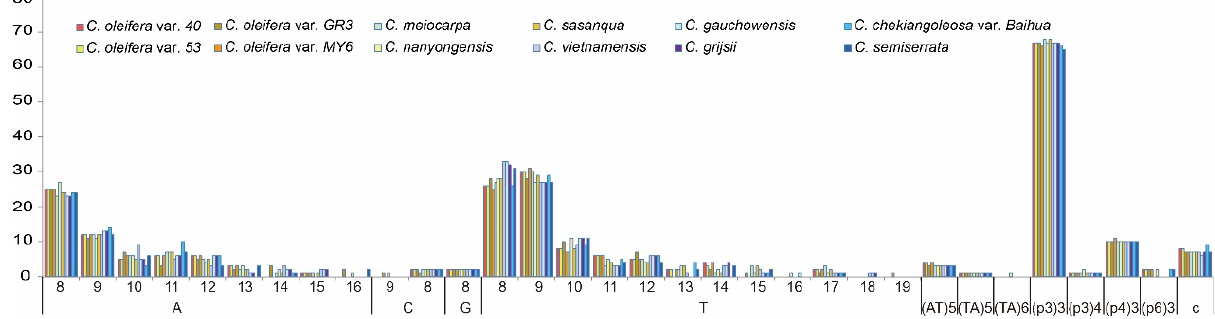
Figure 4. The distribution of SSR motifs in the 12 Camellia cp genomes. p3, p4, p6, and c indicate tri ‐ , tetra ‐ , hexa ‐ , and complex nucleotides, respectively. Table 5. Summary of SSRs in the 12 representative Camellia cp genomes.